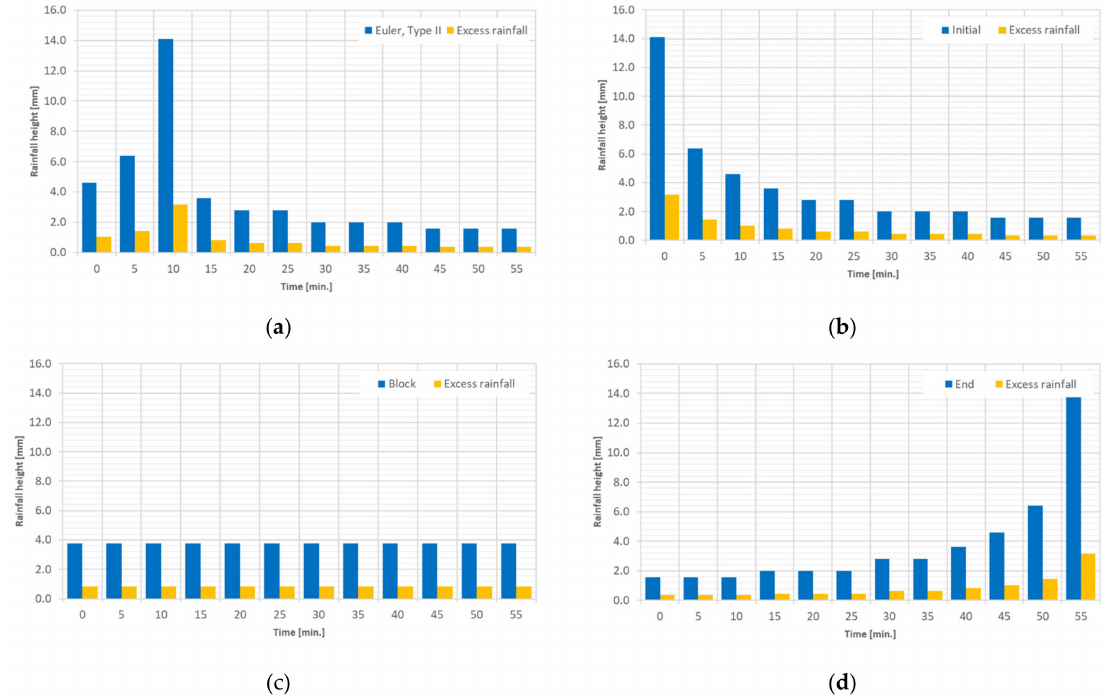
Figure 8. Temporal rainfall distributions ( a ): Euler Type II, ( b ): Initial, ( c ): Block, ( d ): End distribution. As further model settings, a timestep was defined for each mesh resolution, based on the Courant criteria and an assumed maximum velocity within the catchment and stream flow of 5 m/s. The simulation time for the 1 h rain event is set to 24 h so that it is assured that the rainfall runoff event is completed after the end of the simulation. The computational tolerances for water surface and volumes are set to 0.0001 m. The subgrid filter tolerances are reduced to 0.0003 m. Both adjustments are made to assure that shallow water precipitation heights are considered in the computational routine. For the main part, the Diffusion wave approximation is used as an equation set. This adaption is made to accelerate the runtimes and is considered to be physically justifiable, since slope and surface roughness are considered to be the most important driving forces for overland